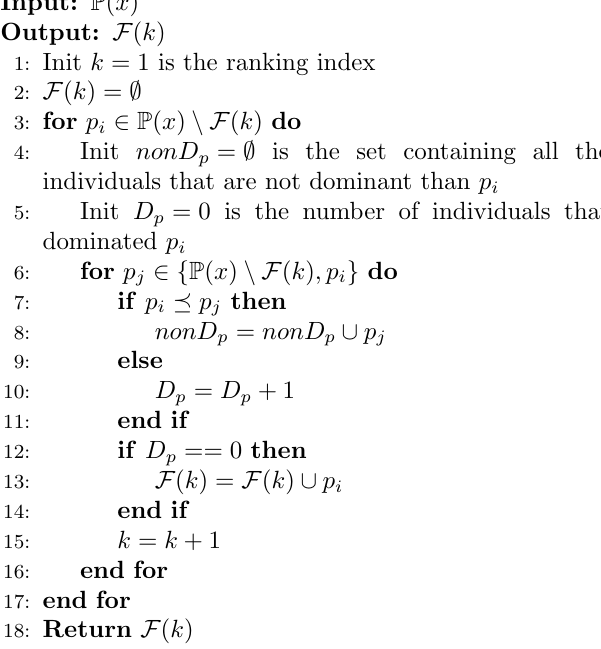
Algorithm 2 Non-dominated Sorting procedure (NdS)